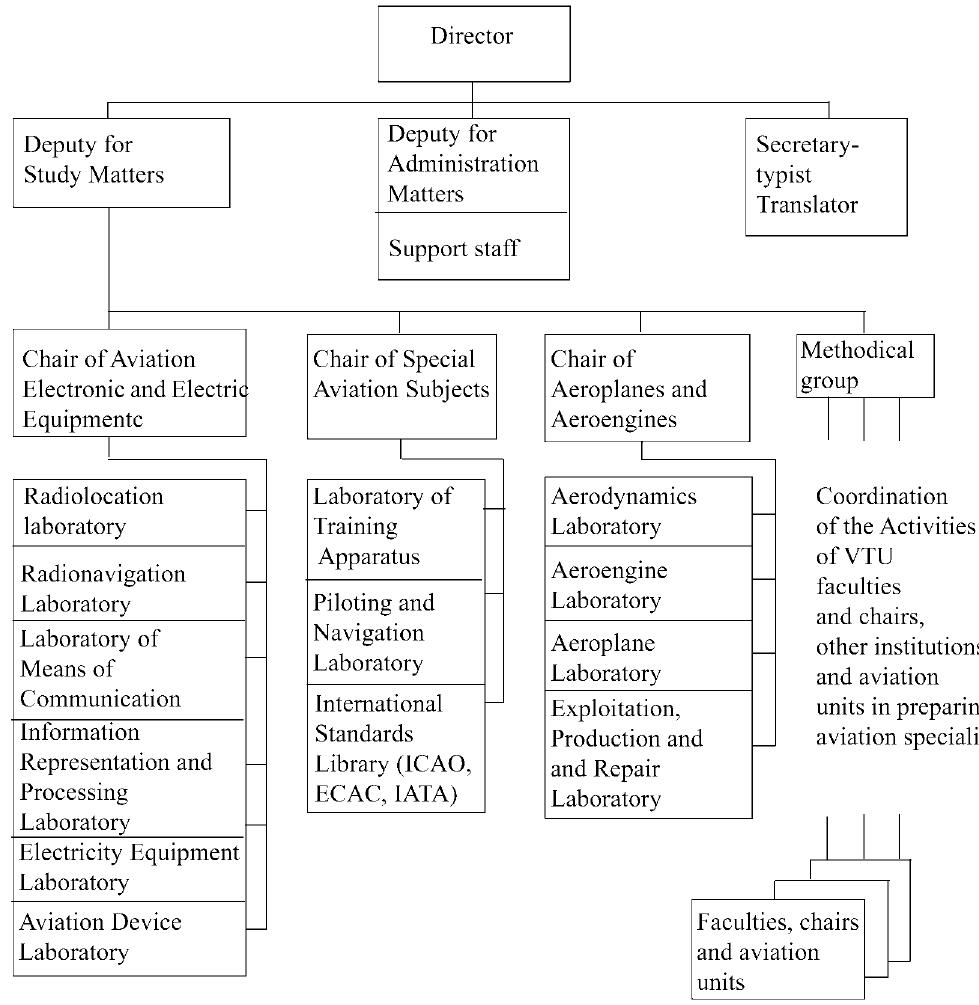
Fig 2. VTU Aviation Institute structure